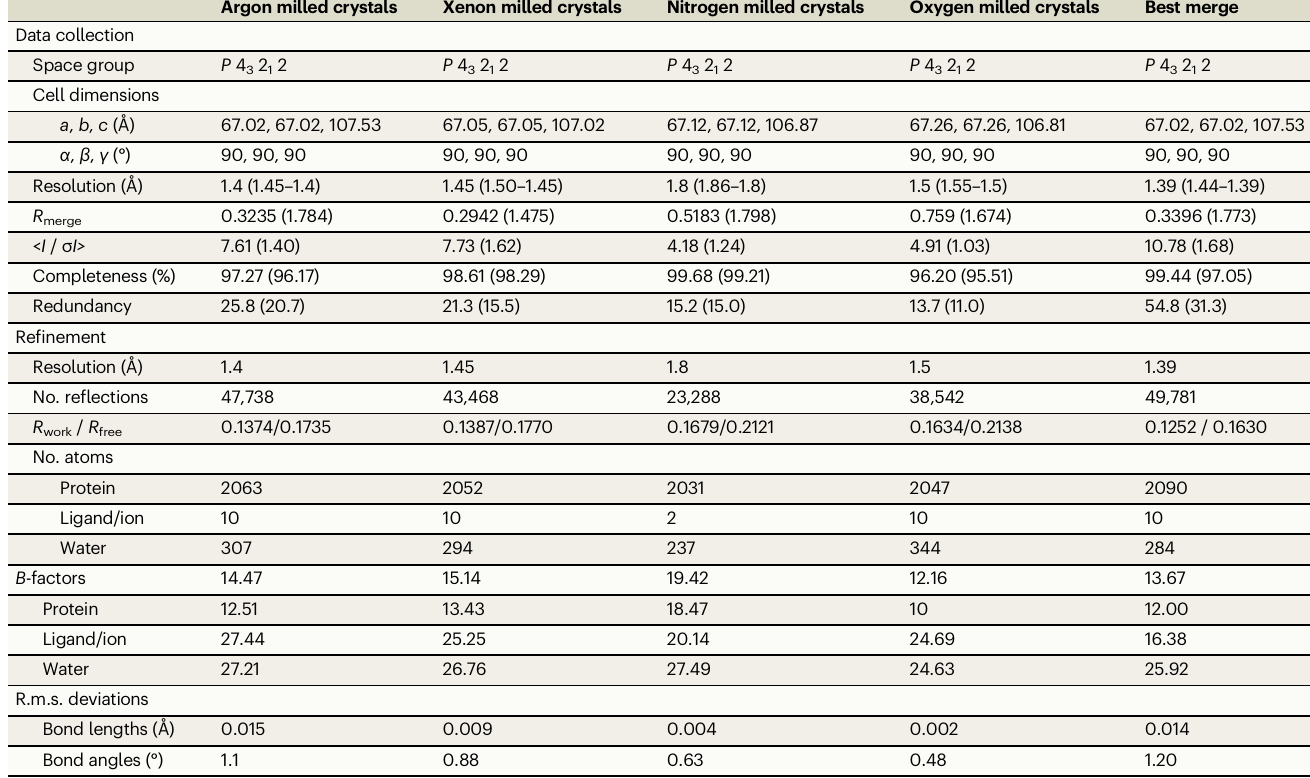
Argon milled crystals Xenon milled crystals Nitrogen milled crystals Oxygen milled crystals Best